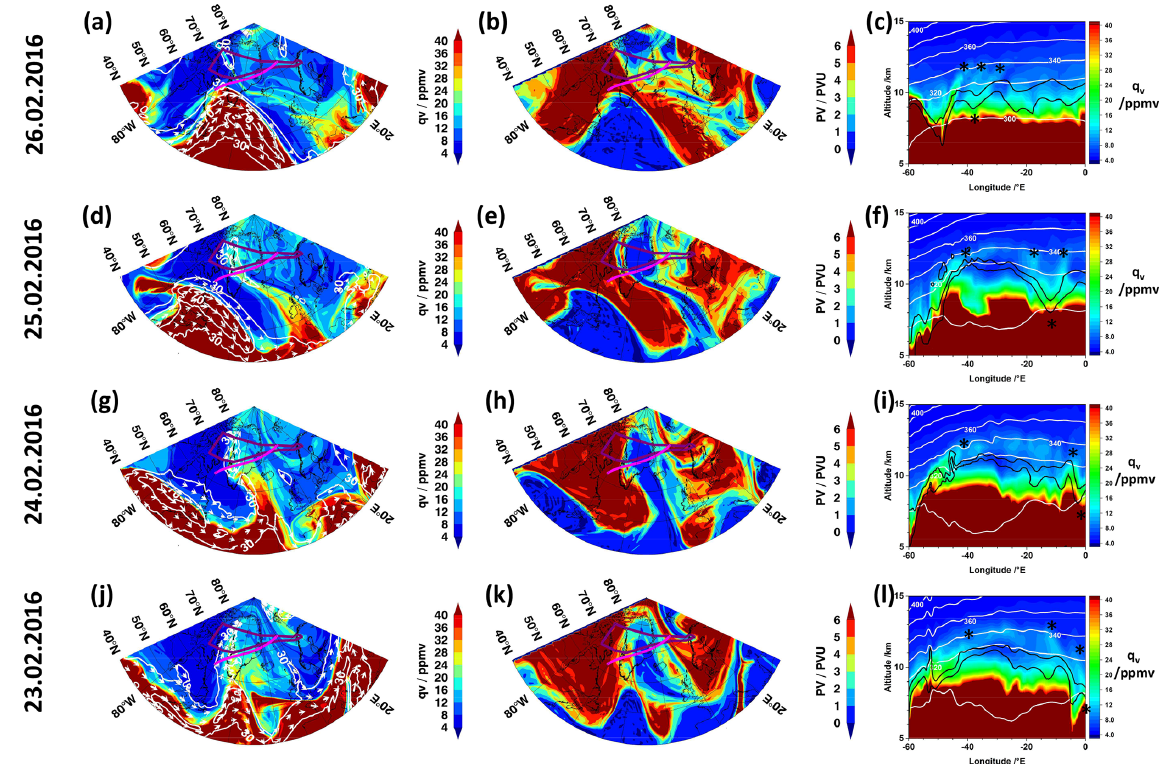
Figure 10. Evolution of filaments in nested ICON-ART domain. (a, d, g, j) Horizontal distribution of q v (coloured contour) and horizontal wind speed (white contour lines – in intervals of 20ms − 1 – and arrows) and (b, e, h, k) PV (coloured contour) at 10km altitude. (c, f, i, l) Vertical distribution of q v (coloured contour; ppmv), potential temperature (white contour lines; in intervals of 20K), and 2 and 4PVU isoline (lower and upper black line) as indicators for the dynamical tropopause. Purple lines in the left and middle column indicate the flight track and magenta lines the location of the vertical cross sections shown in the right column. Stars (c, f, i, l) indicate features in these panels which correspond to features in the other panels out of these. The model data are shown at 12:00UTC of the dates indicated on the